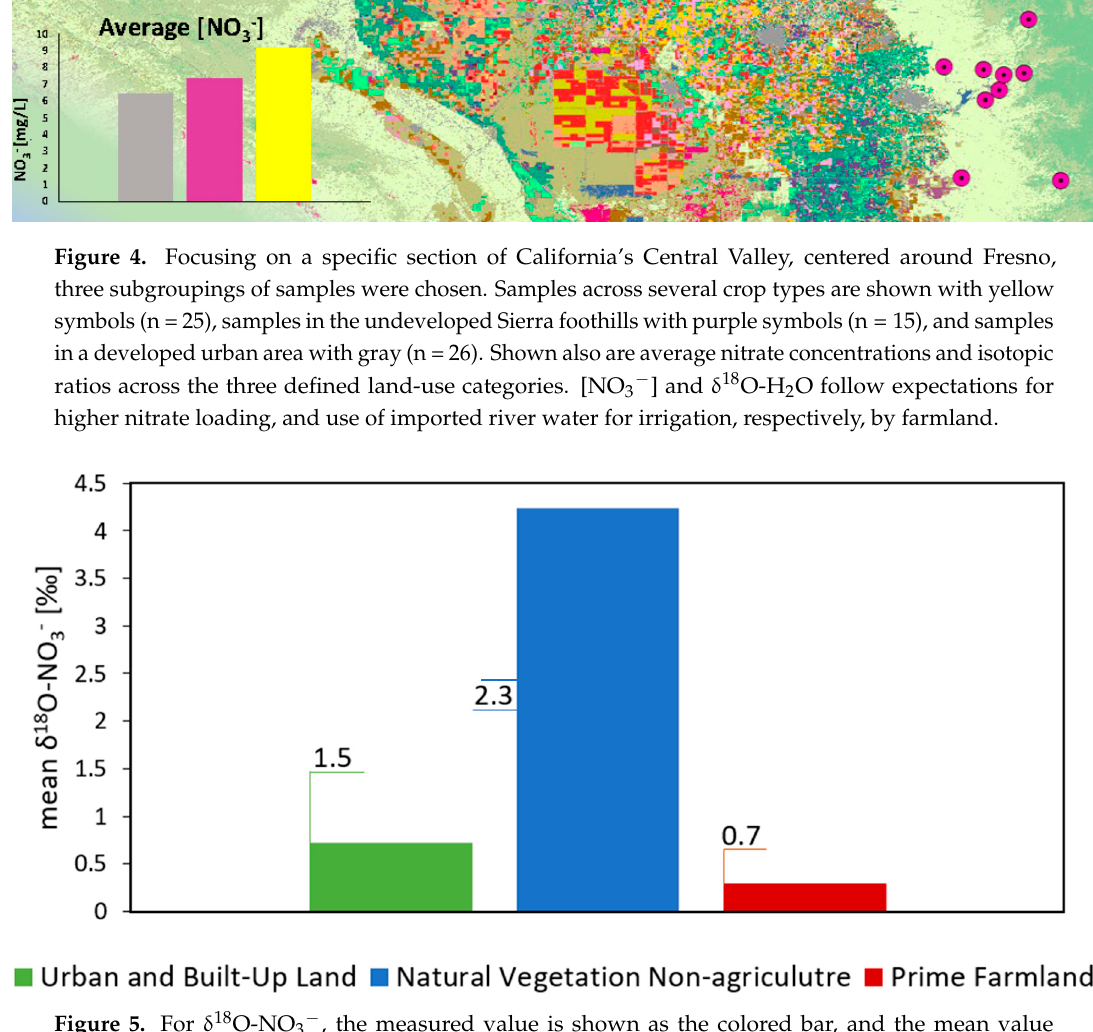
Figure 5. For δ 18 O-NO 3 − , the measured value is shown as the colored bar, and the mean value predicted by Equation 1 (using 23.5‰ for O 2 and the mean measured δ 18 O-H 2 O) is shown in black text.